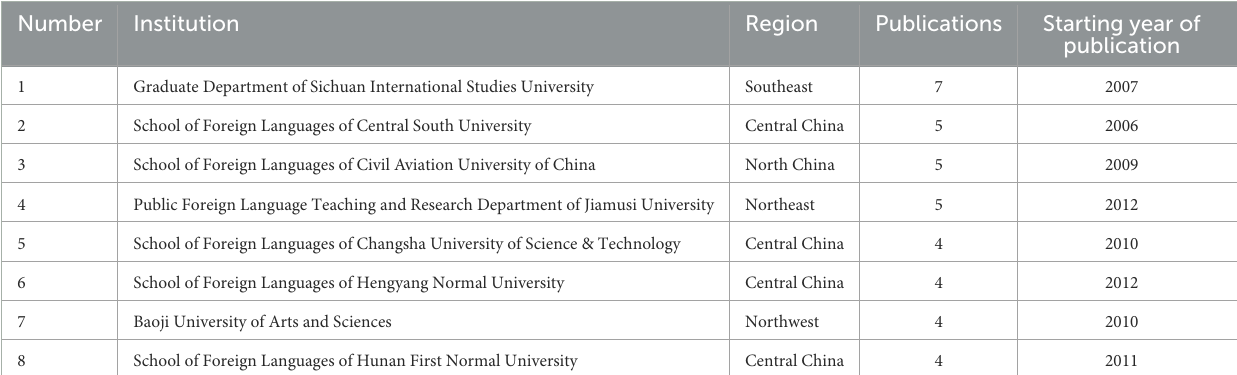
TABLE 1 Top eight Chinese institutions in feminist translation theory.